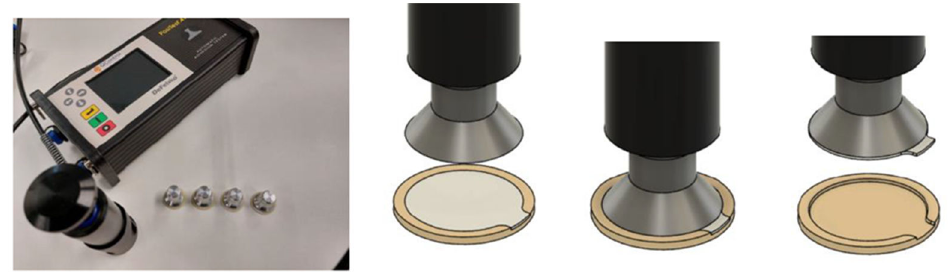
Figure 2. Circular inserts: design, fabricated parts, mould fitting and injection moulding trial.